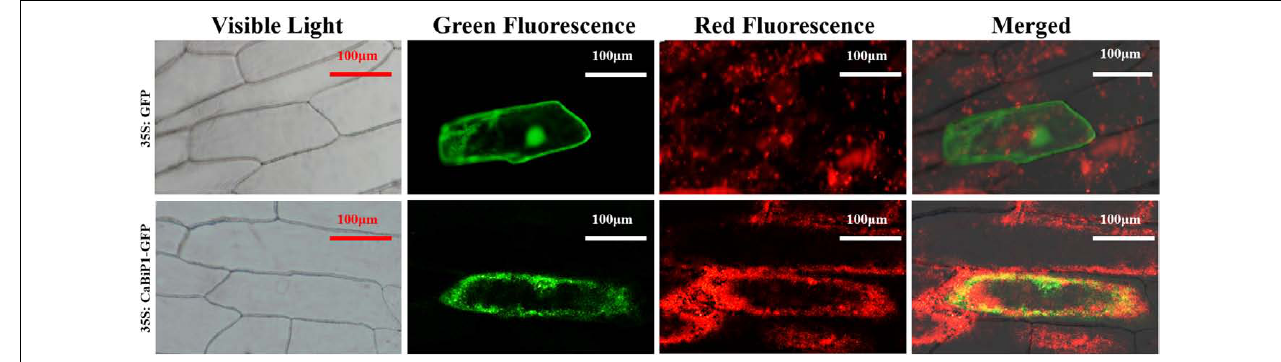
FIGURE 5 | Subcellular localization of the CaBiP1-GFP fusion protein in onion epidermal cells. CaMV35S:GFP was used as the control, and ER-Tracker Red was recruited to mark the ER. CaMV35S, constitutive promoter from the cauliflower mosaic virus. GFP, Bars = 100 µ m. More than 10 transgenic cells were observed, and all of them had the similar result. One of them was presented here.